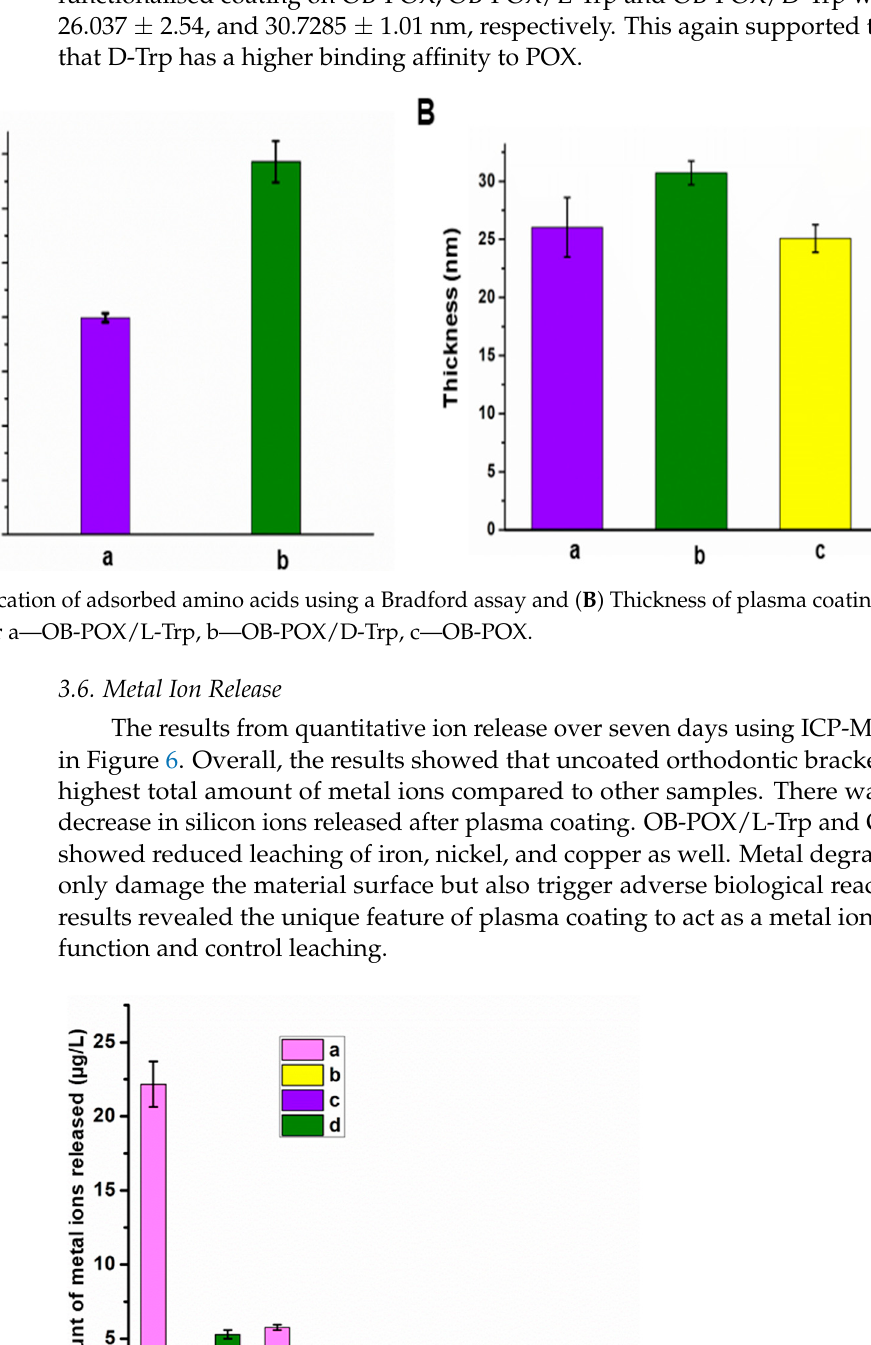
Figure 6. ICP MS analysis of metal ions leached of a—OB, b—OB-POX, c—OB-POX/L-Trp, d—OB- POX/D-Trp incubated in phosphate-buffered saline at pH 7.2 on day 7.